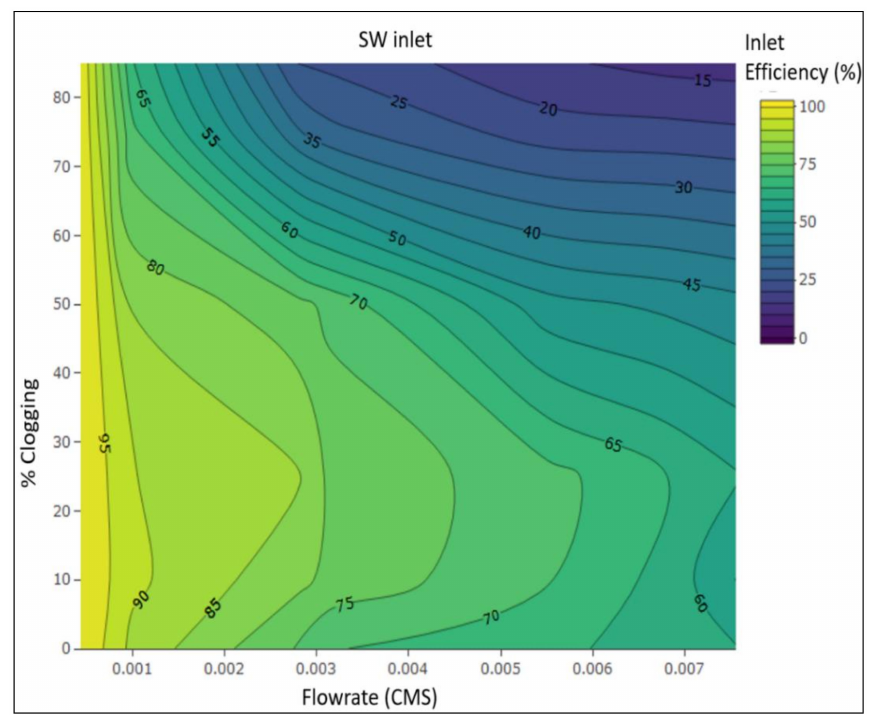
Figure A2. (Reprinted from Shevade et al., 2020). Effect of increased flowrate and inlet clogging on inlet efficiency for SW